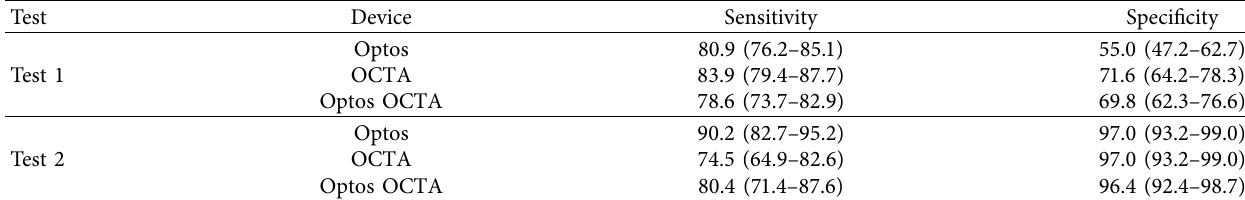
Table 2: Sensitivity and specificity values and 95% confidence